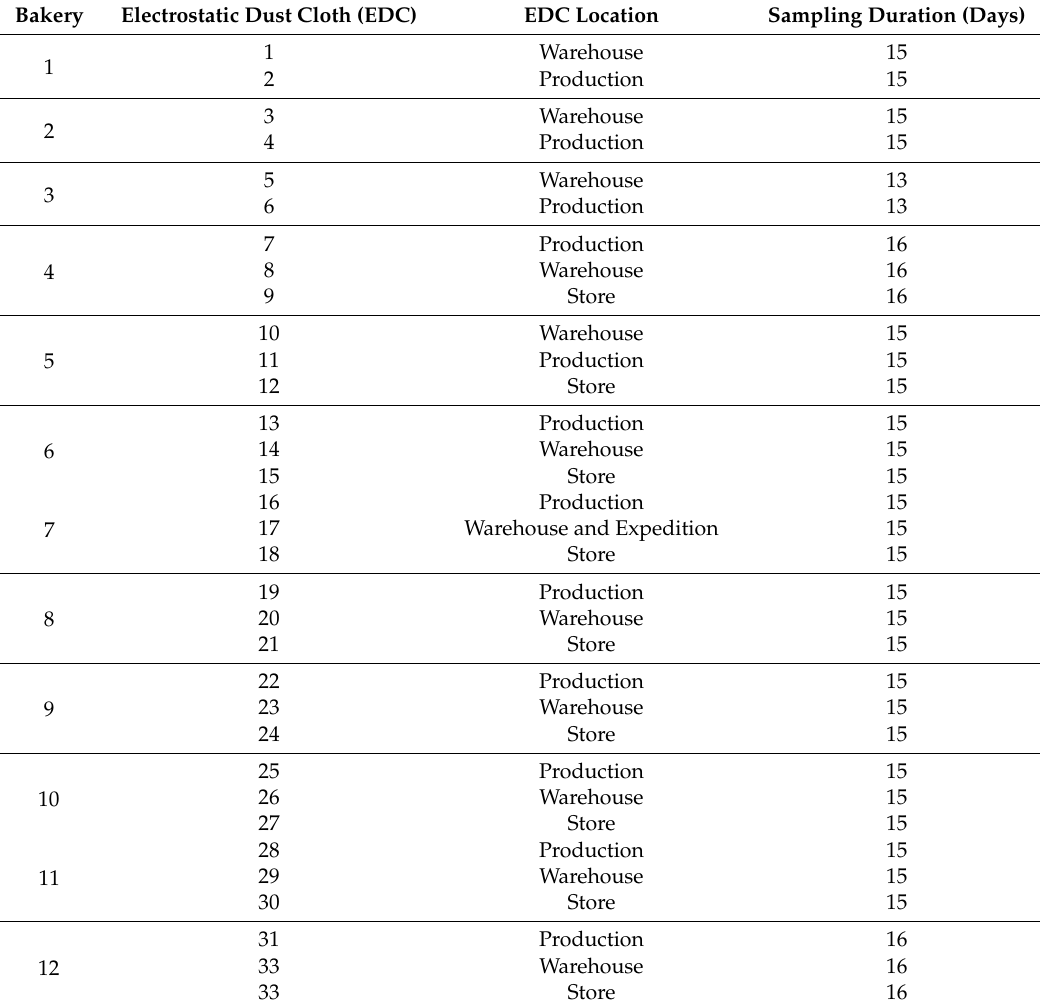
Table 1. Sampling sites